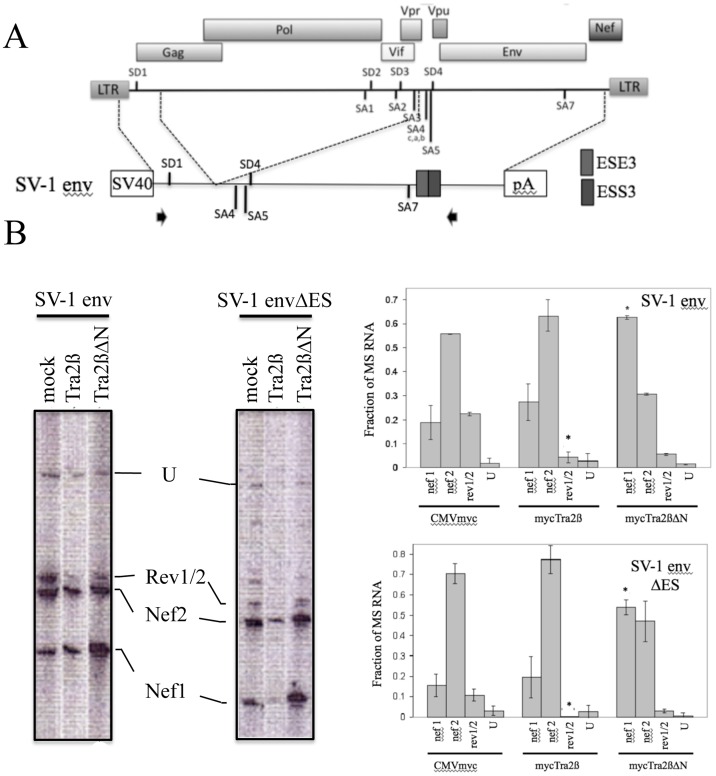
Tra2β Alteration in HIV-1 Splice Site Usage is Independent of ESE3 and ESS3.A, Schematic of the HIV-1 provirus and which viral sequences were used in the generation of the SV-1 env expression vector. Shown is SV40 promoter (SV40), the polyadenylation signal (pA), the position of the splice donors (SD) and splice acceptors (SA) as well as the location of ESE3 and ESS3. SV-1 envΔES was generated by deletion of ESE3 and ESS3. B, 293T cells were transfected with SV-1 env or SV-1 envΔES along with CMVmyc (mock), CMVmyc Tra2β (Tra2β) or CMVmyc Tra2βΔN (Tra2βΔN). RNA was extracted 48h post-transfection and RT-PCR assays performed for HIV-1 MS RNAs as detailed in “Material and Methods”. Shown on the left are representative gels of the RT-PCR products detected and on the right, a summary of the results obtained from n = 3 assays, indicating the relative abundance of a subset of the RT-PCR products detected; U designates unspliced RNA. Asterisks indicated values deemed significant from control (mock) at p<0.05.